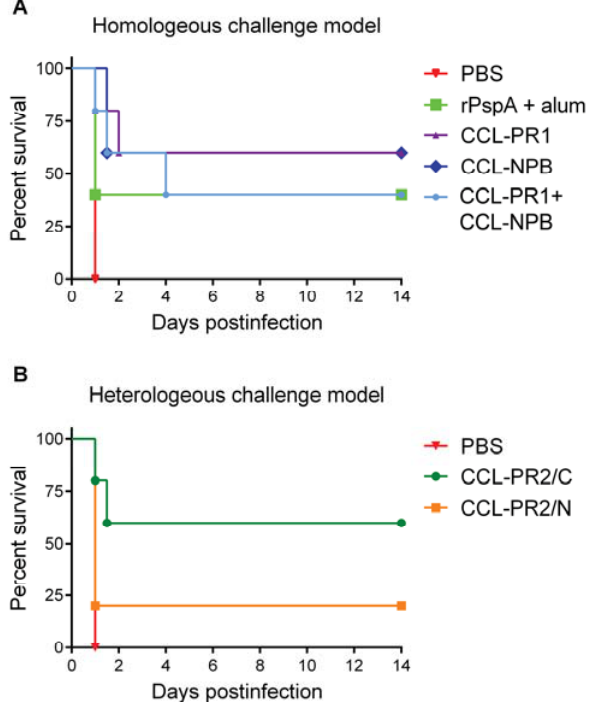
Figure 5. Evaluation of the protective efficacy of peptide-loaded SVLP vaccine candidates in an experimental mouse infection model. NMRI outbred mice were immunized